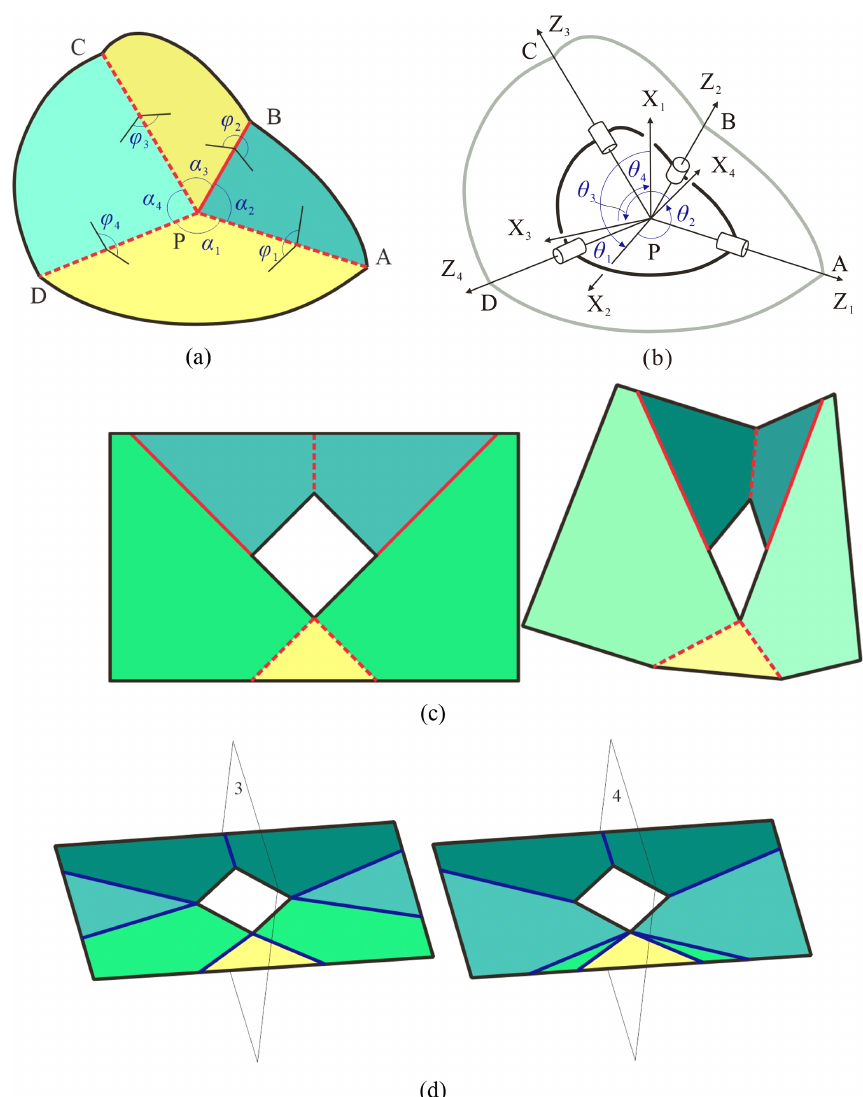
Figure 2. (a) The origami with four creases. (b) The local coordinate systems on the equivalent 4 R linkage. (c) The movable five-crease pattern becomes a 2-DOF spherical 5 R linkage. (d) Two possible seven-crease patterns are not